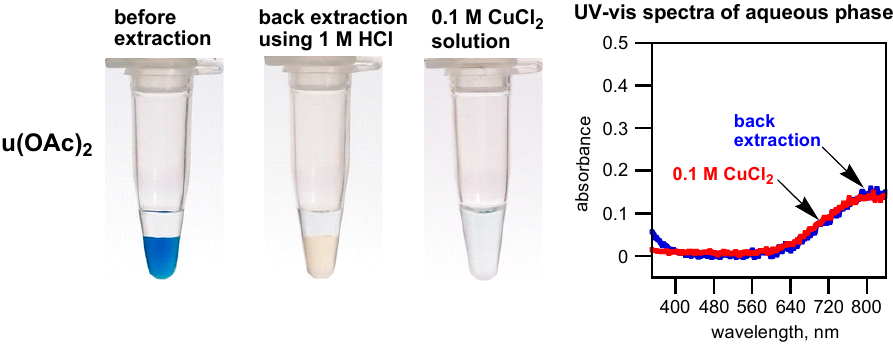
Figure 5. Optical photographic images and UV-vis spectra of competitive extraction of Cu(OAc) 2 (0.1 M) and AIL 3 (0.25 M) in ionic liquid 2 (25 μ L) by 1 M HCl in H 2 O (25 μ L). A photograph of 0.1 M CuCl 2 aqueous solution (50 μ L) was also included for comparison.